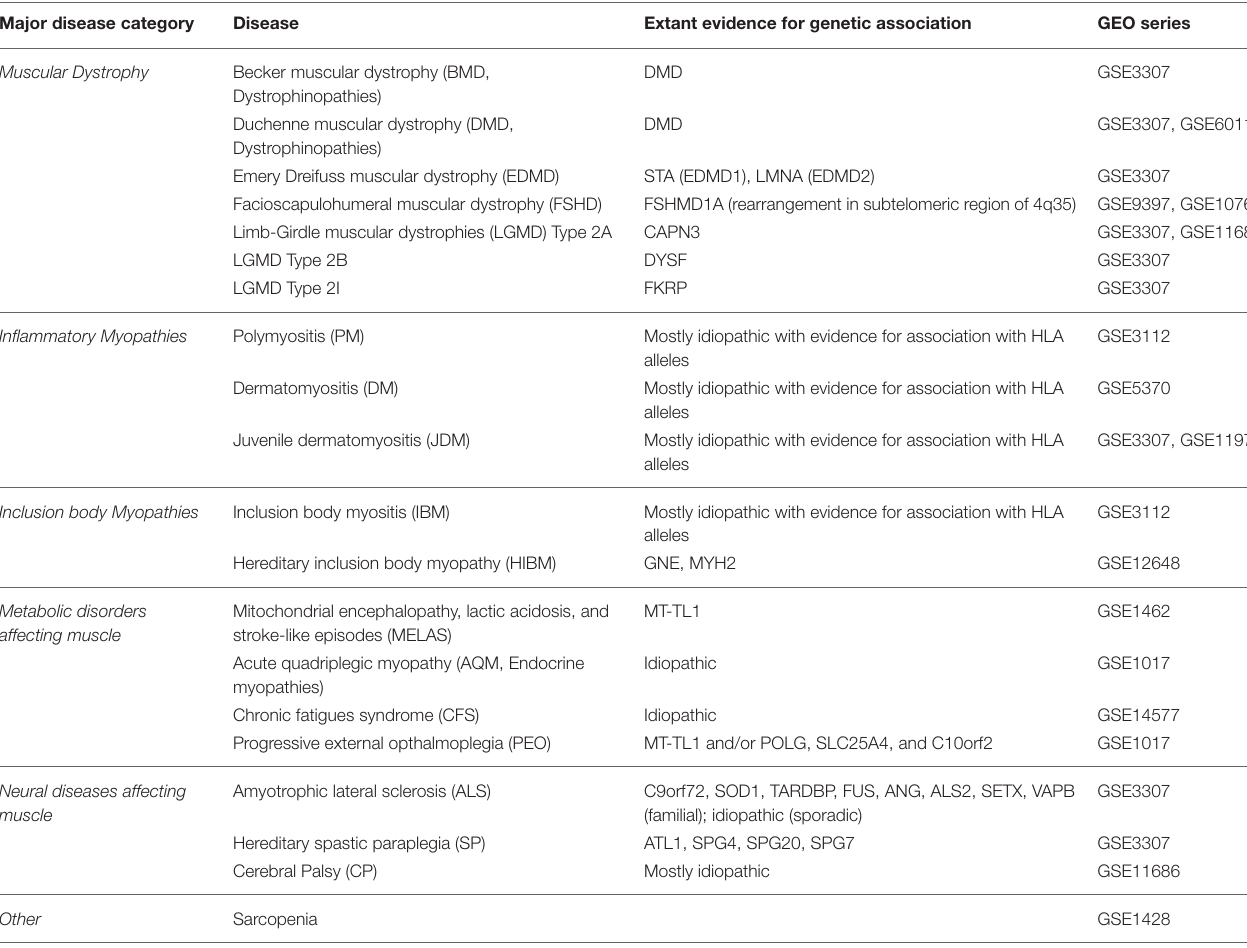
TABLE 1 | Diseases affecting